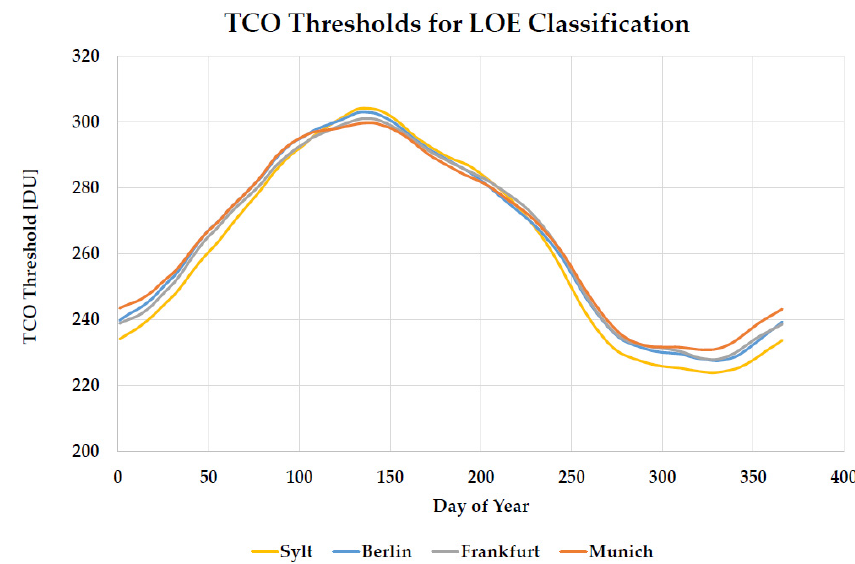
Figure 2. Thresholds of the TCO for Sylt (yellow line), Berlin (blue line), Frankfurt (grey line), Munich (orange line) depending on the day of the year for a classification as LOE (TCO).